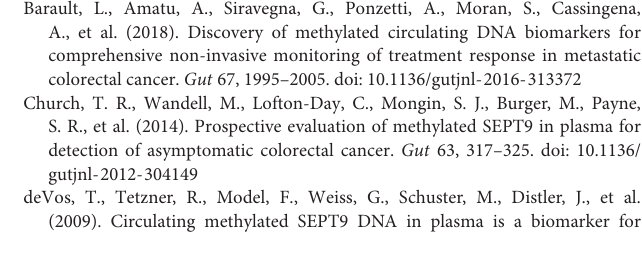
Supplementary Figure 1 | The Mean methylation rate of the candidate zinc finger genes in the CRC tumors, adenomas and control tissues. The y-axis represents the mean methylation percentage in the CRC tumor tissues and paired normal tissues for each CpG site. The error bar of each CpG site represents the confidence interval of the methylation percentage. Supplementary Figure 2 | Bisulfite conversion rate and mapping rate between CRC tumors and para-tumors. Panels (A,B) represent the bisulfite conversion rate and the reads mapping rate of the samples in replication cohort 1, respectively. Supplementary Figure 3 | Principal Component Analysis of the methylation profiles of the samples in replication cohort 1. All of the CpG sites were preprocessed and simplified into the two-variable space through principal component analysis. The green and red dots represented the CRC tumors and paired controls in replication cohort 1. Supplementary Figure 4 | Boxplot of the methylation rate of the KRAS + , KRAS- and control samples in replication cohort 1. The mean methylation rate of all the CpG sites in each candidate gene of each sample was depicted as one dot in the boxplot. Supplementary Figure 5 | Bisulfite conversion rate and mapping rate between CRC tumors and para-tumors. Panels (A,B) represent the bisulfite conversion rate and the reads mapping rate of the samples in replication cohort 2, respectively. Supplementary Figure 6 | Principal Component Analysis of the methylation profiles of the samples in replication cohort 1. All of the CpG sites were preprocessed and simplified into the two-variable space through principal component analysis. The green and red dots represented the CRC tumors and paired controls in replication cohort 2. Supplementary Figure 7 | Boxplot of the methylation rate of the KRAS + , KRAS- and control samples in replication cohort 2. The mean methylation rate of all the CpG sites in each candidate gene of each sample was depicted as one dot in the